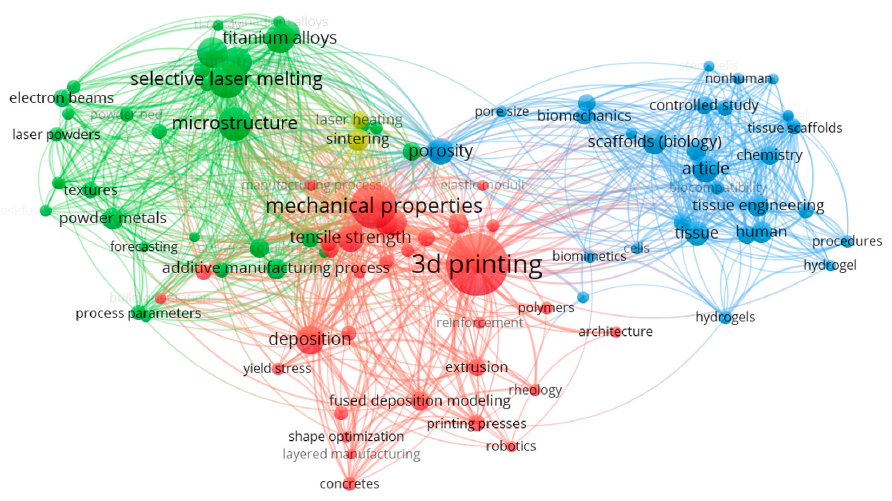
Figure 4. Fractional analysis of the co-occurrence network.